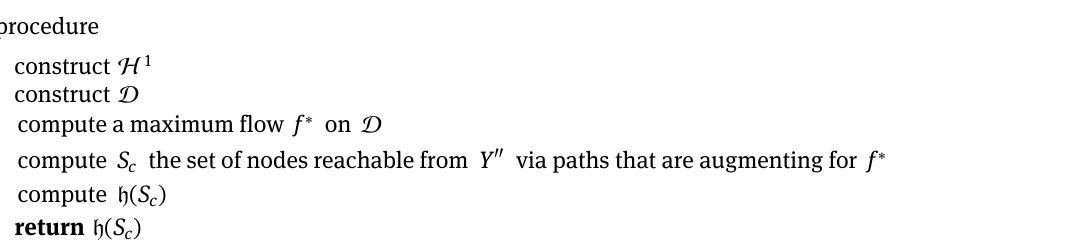
Algorithm 1 : Pseudo - algorithm to compute O c